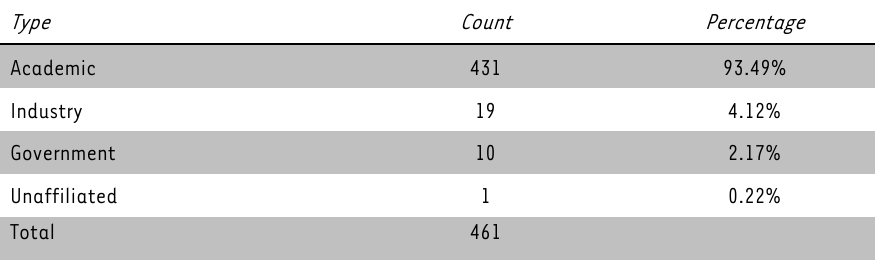
TABLE 6: Author affiliation